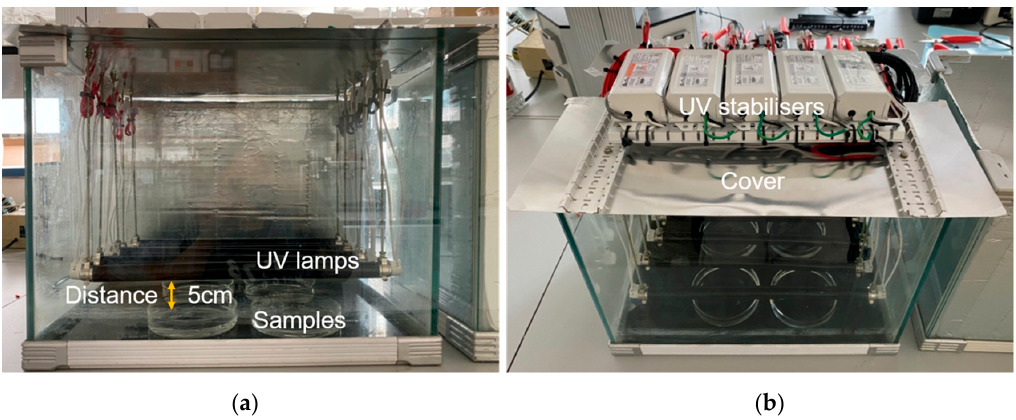
Figure 2. Example of one of the three reaction chambers constructed. ( a ) Sideview of the chamber showing the location of the samples, ultraviolet (UV) lamps and distance between the UV lamps and the sample. ( b ) Top-view showing the placement of UV stabilisers and the aluminium cover.